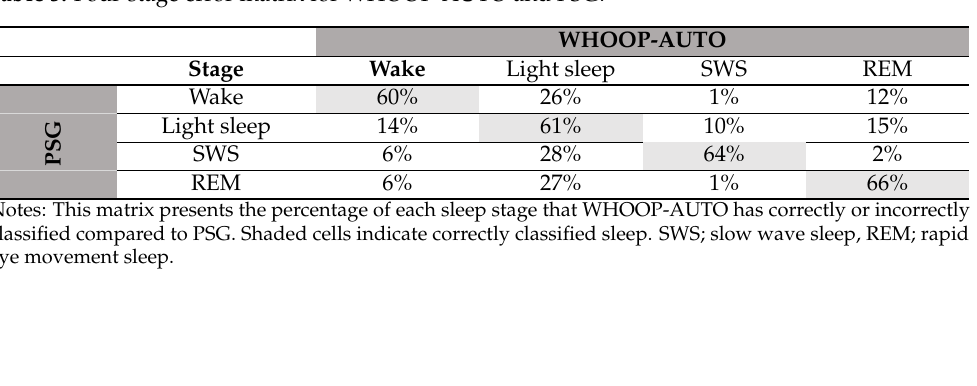
Figure 2. Bland–Altman plots for WHOOP-AUTO and PSG-derived measures of ( A ) total sleep time (TST), ( B ) wake time, ( C ) light sleep, ( D ) slow wave sleep (SWS), ( E ) rapid eye movement sleep (REM). Data points represent one sleep opportunity. The x-axes represent the mean of the values obtained from WHOOP-AUTO and PSG. The y-axes represent the difference between the values, such that positive values indicate that WHOOP-AUTO overestimates relative to PSG and negative values indicate that WHOOP-AUTO underestimates relative to PSG. Solid horizontal lines indicate the mean bias from PSG, and broken lines indicate the 95% limits of agreement (±1.96 standard deviations) [20]. Table 3. Four-stage error matrix for WHOOP-AUTO and